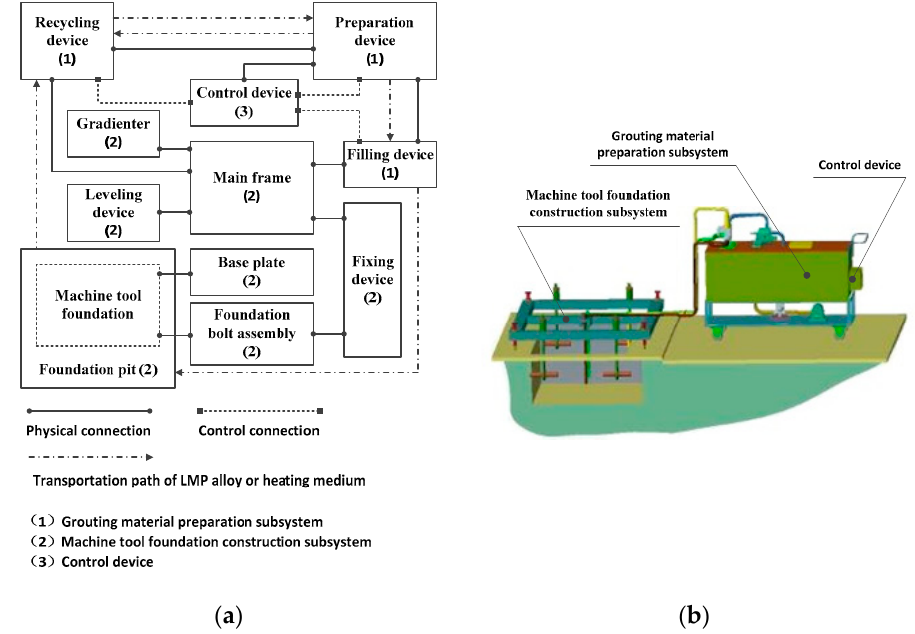
Figure 4. Structural layout and 3D model of the system. ( a ) Basic structural layout; ( b ) 3D model.